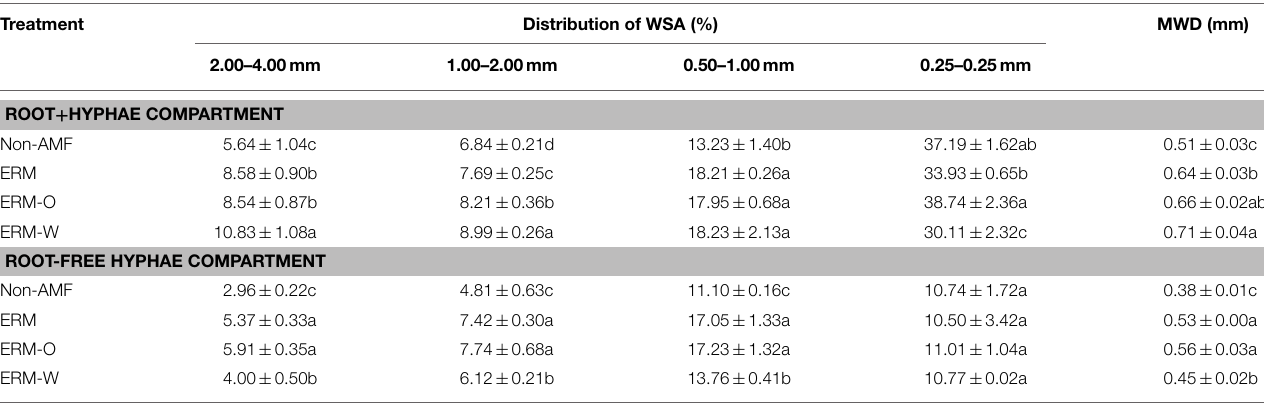
TABLE 3 | Distribution of water-stable aggregate (WSA) and mean weight diameter (MWD) in 37 µ m nylon-mesh separated root/hyphae compartments of trifoliate orange inoculated with or without Funneliformis